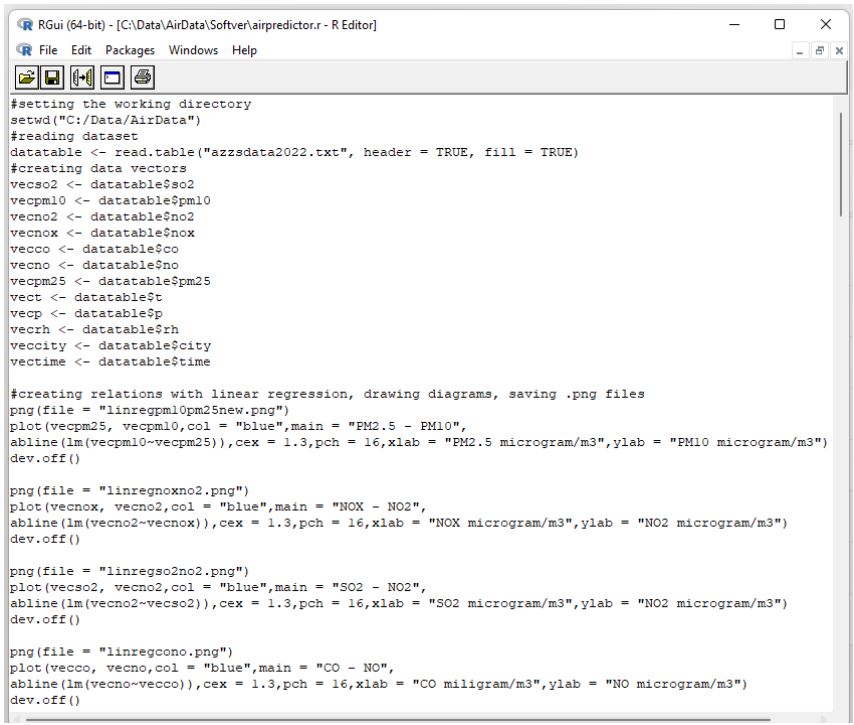
Figure 3. Created the first part of the R program with creating data vectors, relations with linear regression, and drawing diagrams in the R GUI.